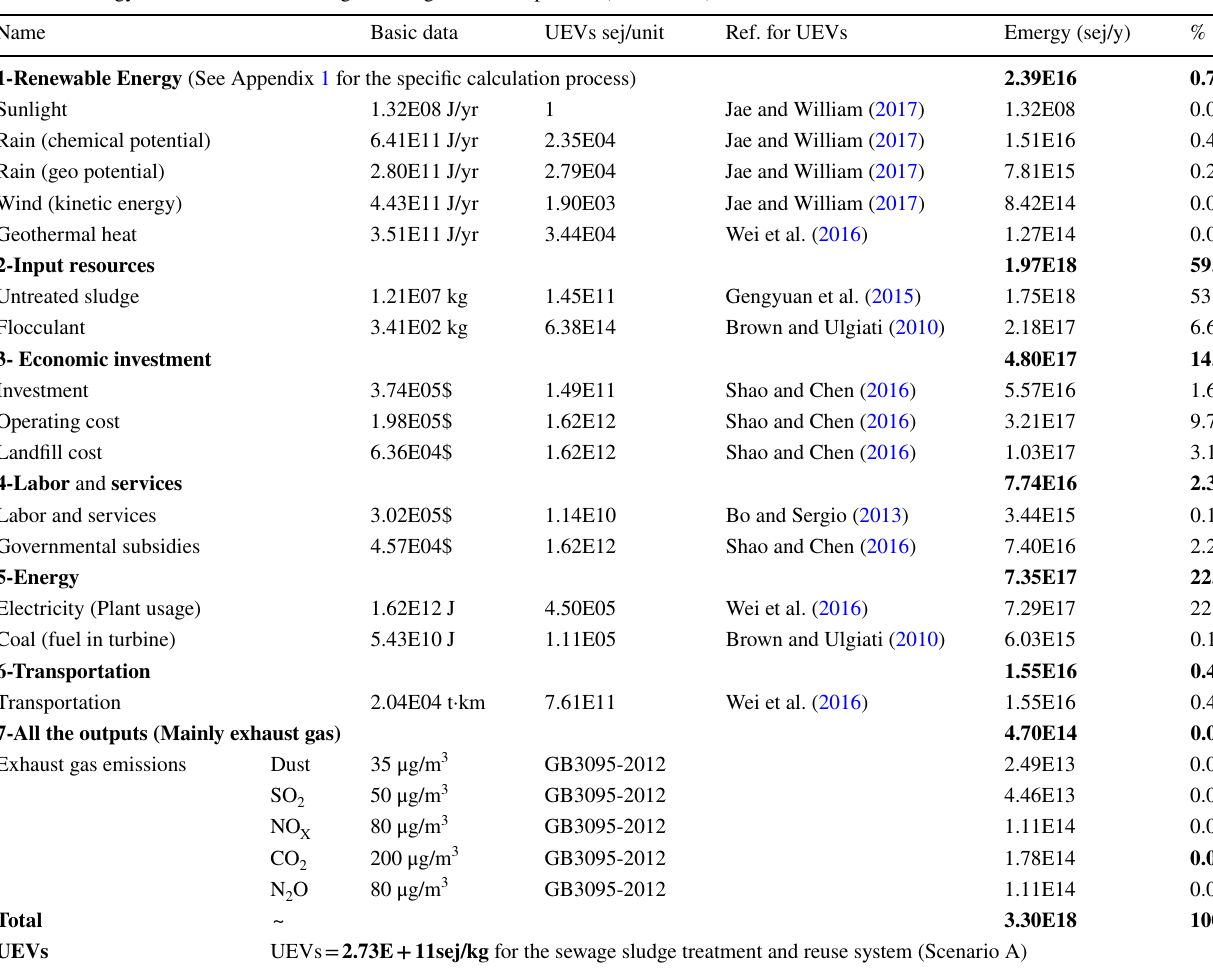
Table 5 Emergy calculated details of original sludge treatment process (Scenario